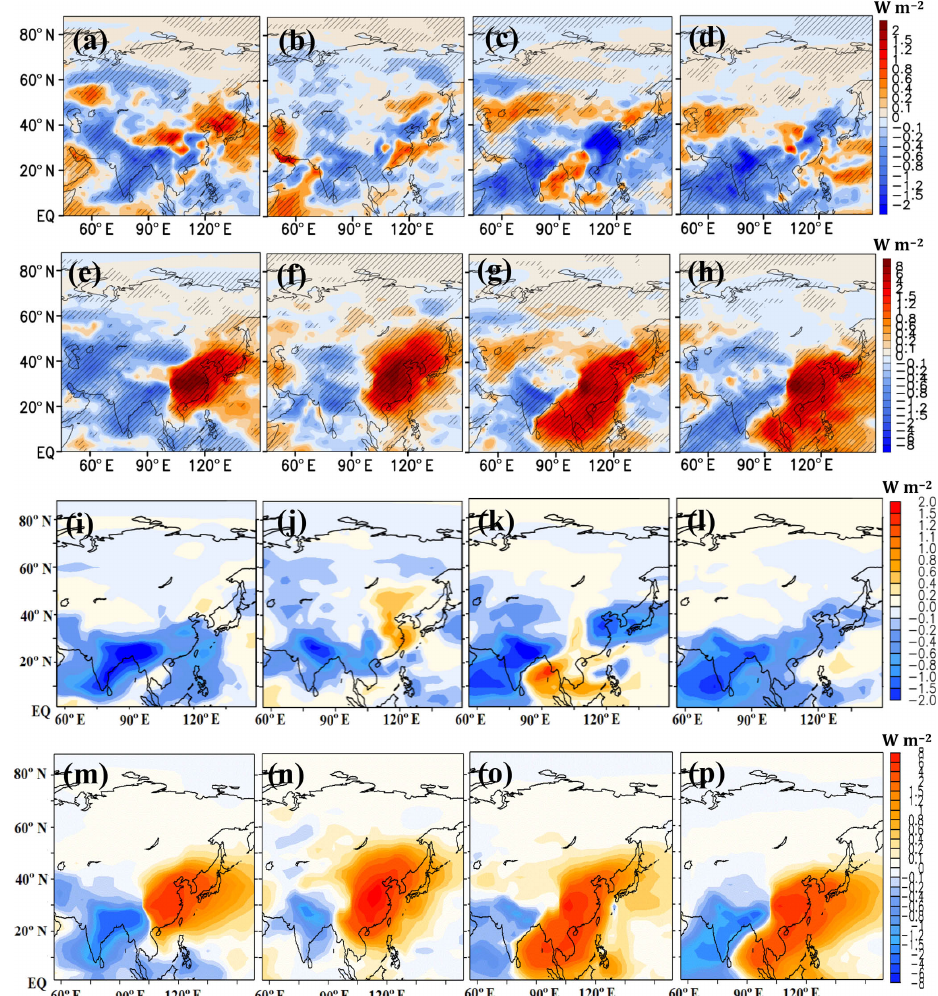
Figure 6. Seasonal distribution of anomalies in clear-sky direct net radiative forcing (Wm − 2 ) simulated by ECHAM6–HAMMOZ at the top of the atmosphere, from Ind48-CRTL simulations for the (a) pre-monsoon (b) summer-monsoon, (c) post-monsoon and (d) winter seasons; (e) – (h) same as (a) – (d) but from Ind48Chin70-CTRL simulations; (i) – (l) same as (a) – (d) but from the offline model; (m) – (p) same as (e) – (h) but from the offline model. The black hatched lines in (a) – (h) indicate the 99% significance